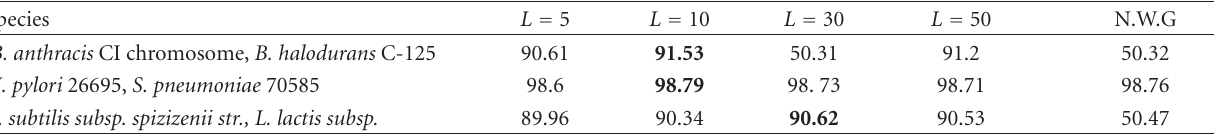
Table 2: Performance of Poisson mixture model on datasets for di ff erent values of L and word length of 5. Here, N.W.G stands for no word grouping. The maximum accuracy achieved is in bold. Each dataset contains 50,000 reads of length 500 bp. Species